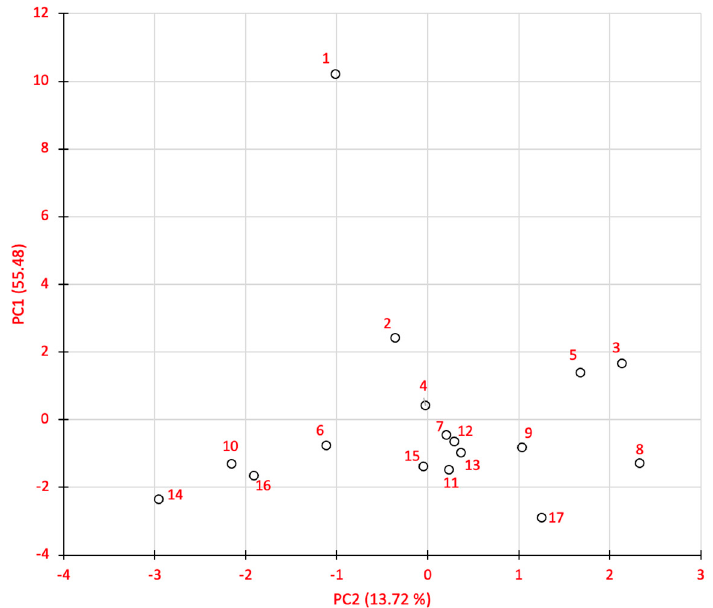
Figure 5. Principal component analysis (PCA) of physical, chemical and bioactive characteristics of the onion bulb.